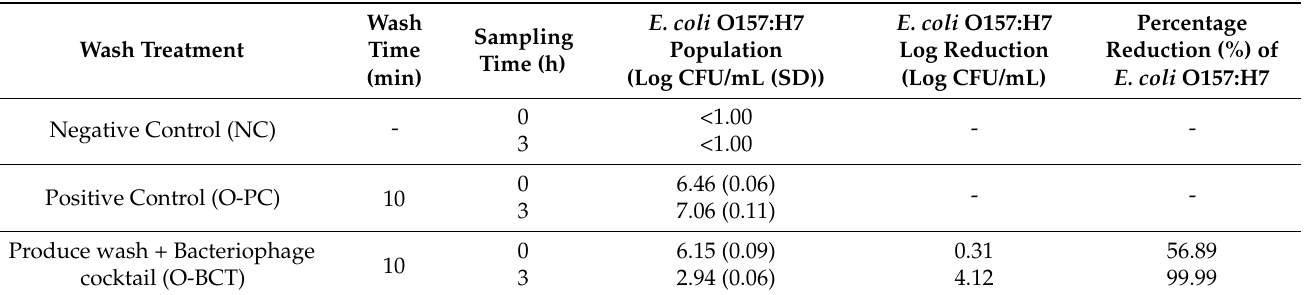
Table 2. Reduction of E. coli O157:H7 (ATCC 35150) on spinach via postharvest pathogen control measures when using bacteriophage cocktail wash solution made with water containing 9810 ppm of organic load in a simulated dunk tank. The data and standard deviation (SD) represent the mean of triplicate